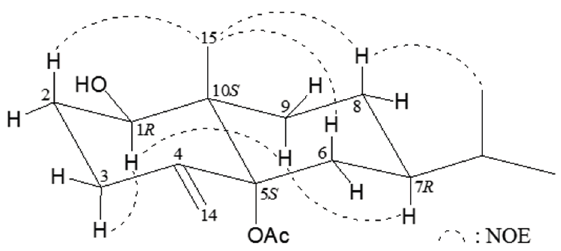
Figure 2. Important nuclear overhauser effect spectroscopy (NOESY) correlations for compound 2